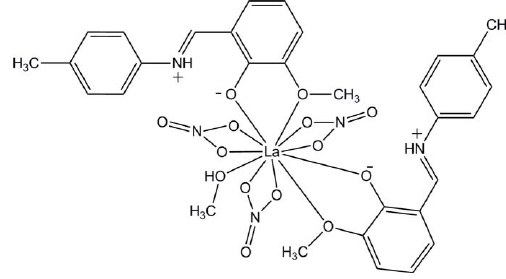
Bruker APEXII CCD area-detector diffractometer Absorption correction: multi-scan ( SADABS ; Sheldrick, 1996) T min = 0.634, T max = 0.783 Refinement R [ F 2 > 2 (cid:2) ( F 2 )] = 0.034 wR ( F 2 ) = 0.101